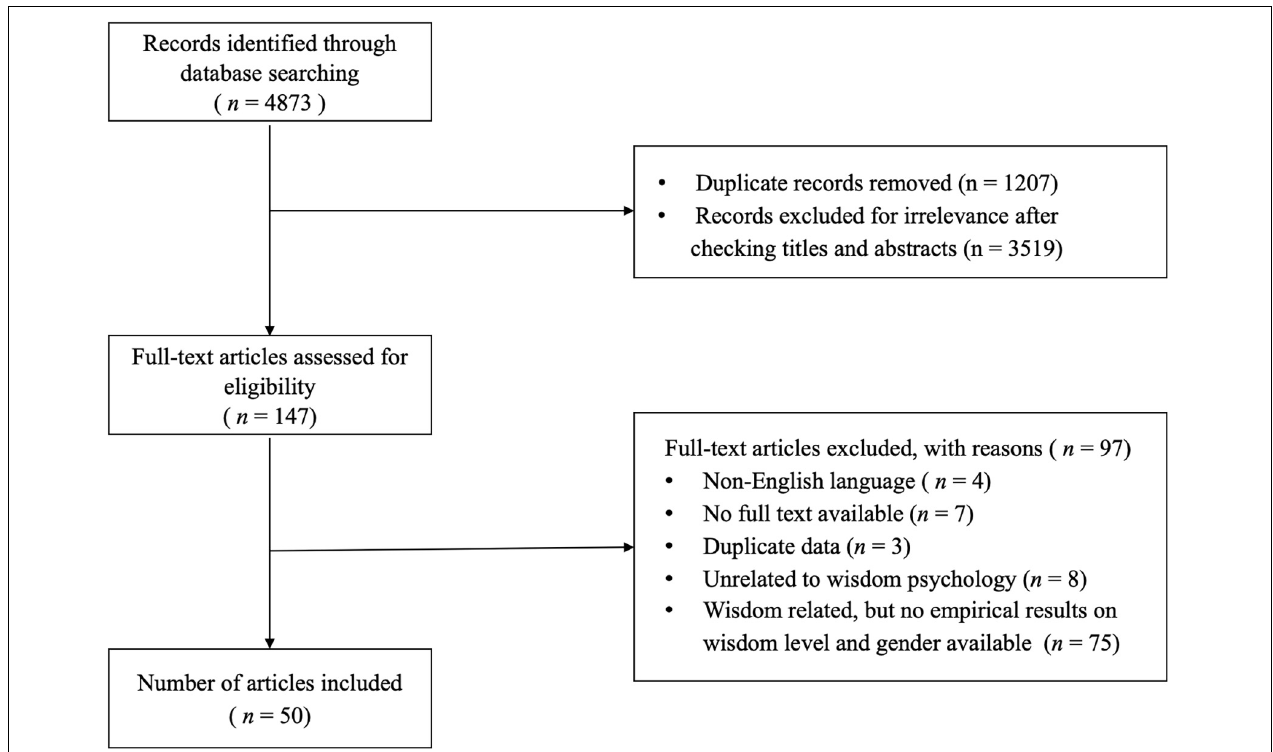
FIGURE 1 | Flow diagram for included studies in the systematic